Question: State the chart type depicted above.
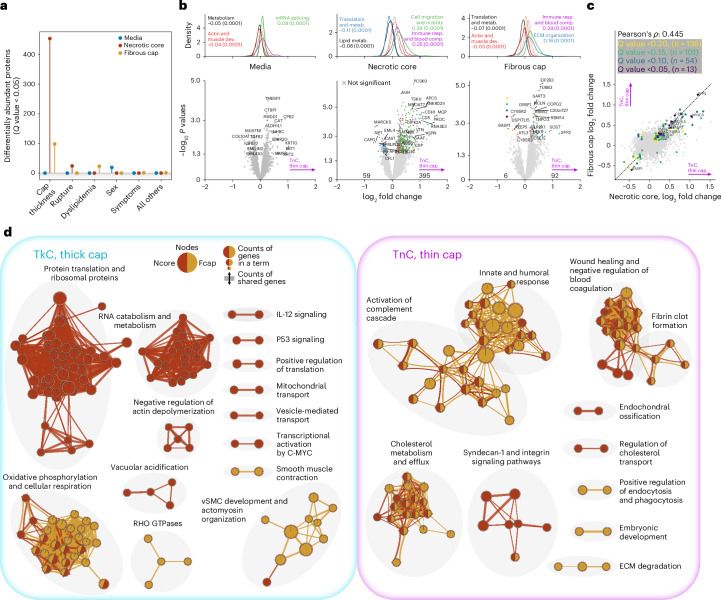
Answer: pie